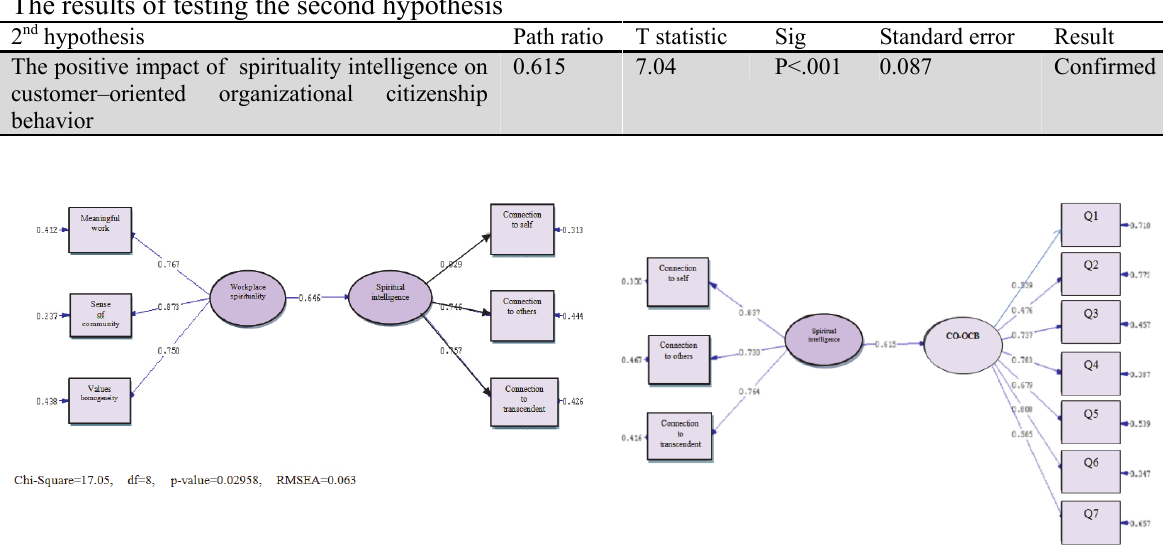
Fig. 3. the estimation model of the impact by “workplace spirituality” on “spiritual intelligence”